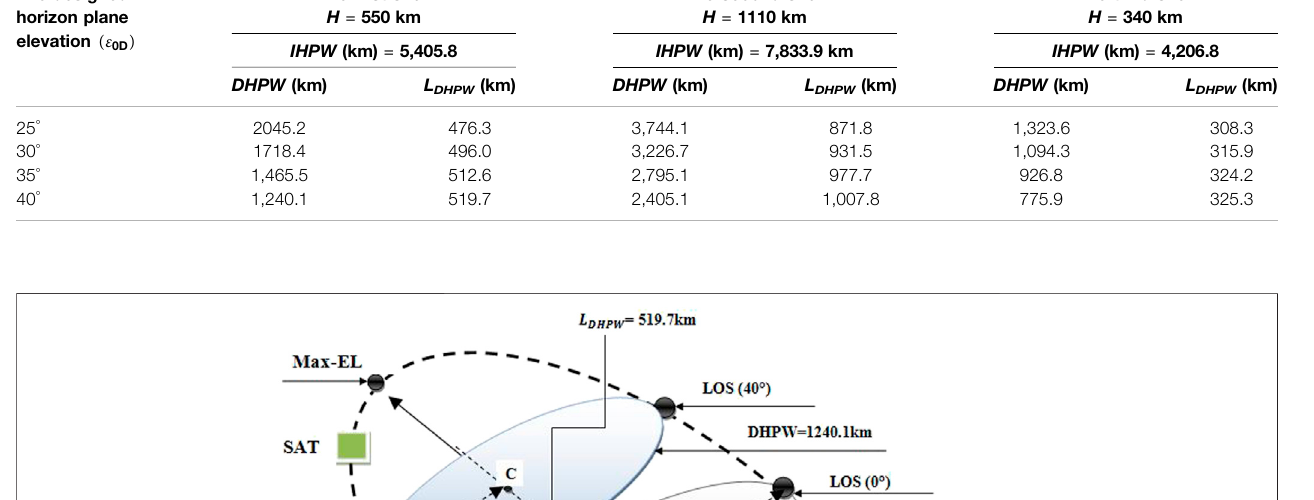
TABLE 3 | IHPW , DHPW , and L DHPW for the different shells. The designed horizon plane